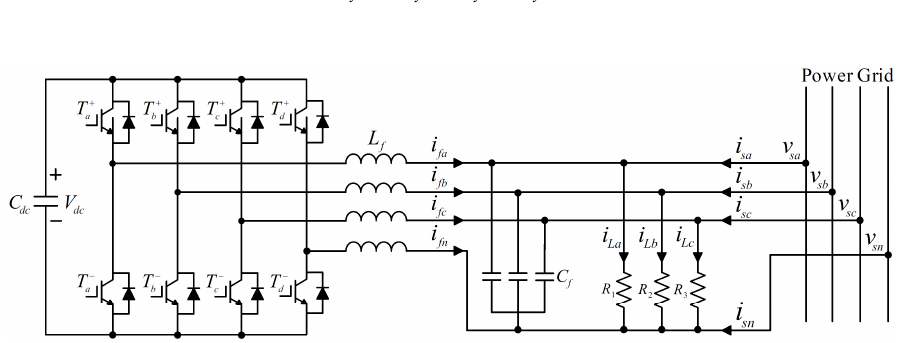
Figure 1. Circuit scheme of three-phase four-leg inverter-based shunt APF in grid-connected operation.